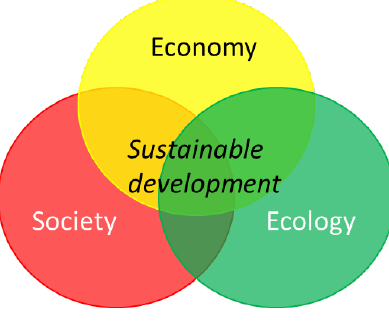
Fig. 1. Sustainable development